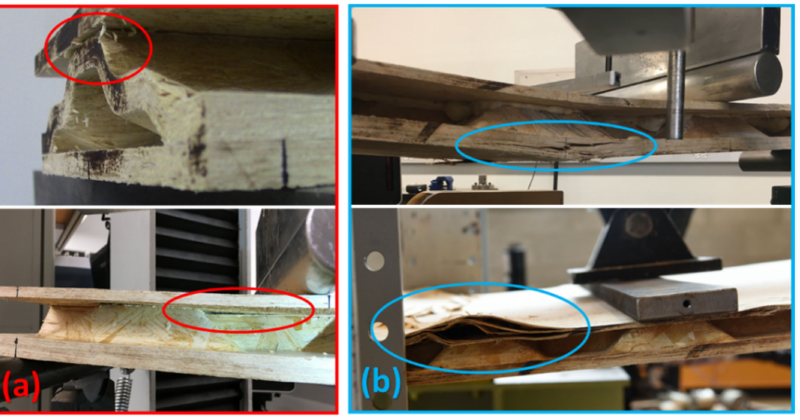
Figure 7. Failure mode of one-layered core sandwich panel ( a ) interfacial debonding ( b ) tension or compression in